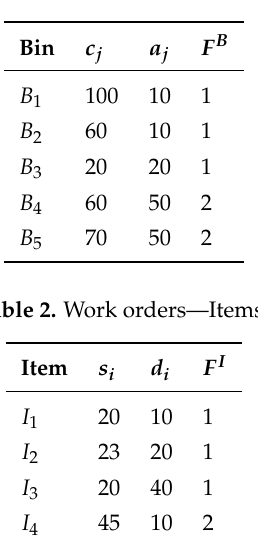
Table 1. Purchase orders—Bins.